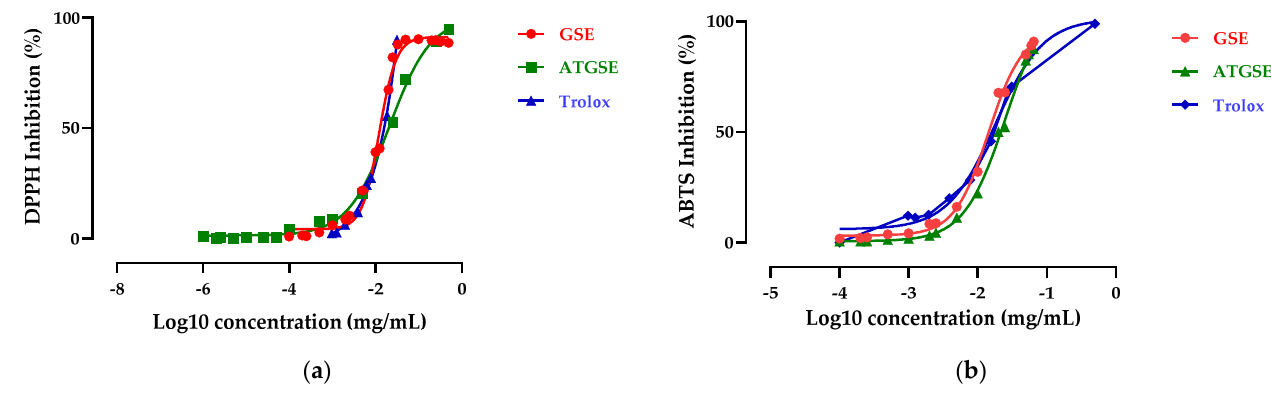
Figure 3. Antioxidant activity of GSE, ATGSE, and Trolox expressed as ( a ) EC 50 of DPPH assay and ( b ) EC 50 of ABTS assay. Values are the mean ± standard deviation (SD) of three replications.